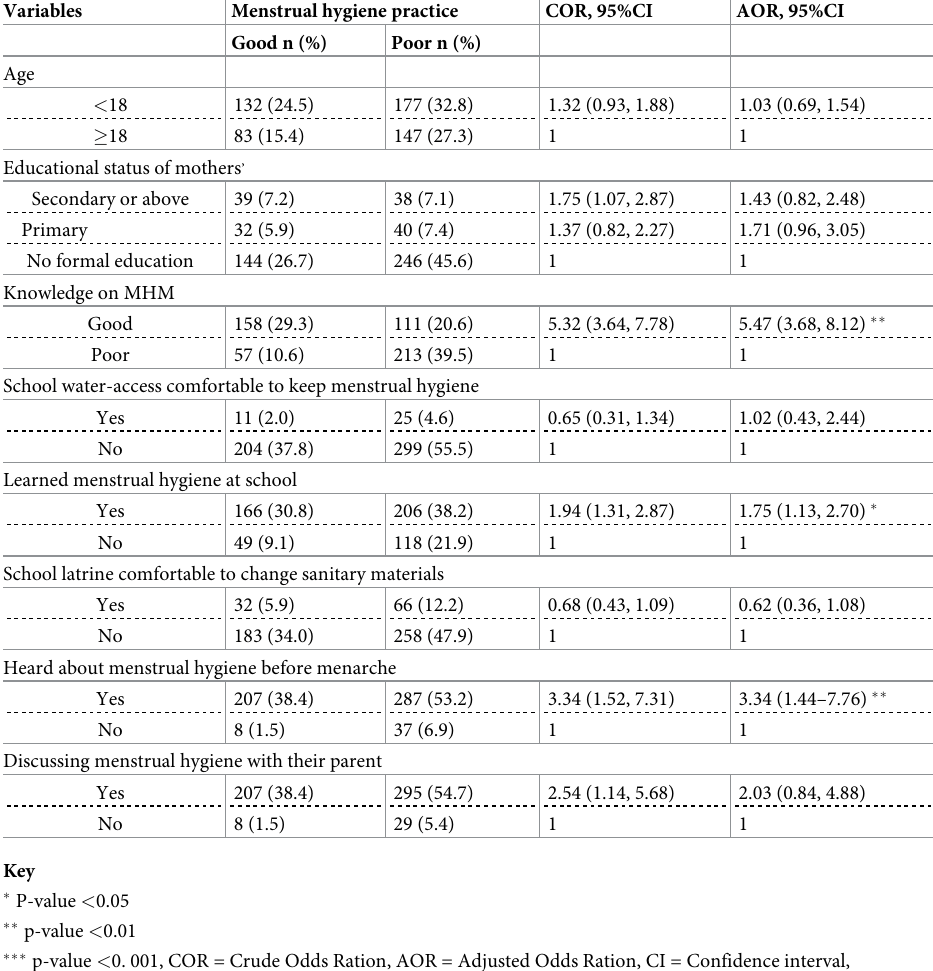
Table 5. Factors associated with menstrual hygiene management practice among rural schoolgirls in Northeast, Ethiopia, 2020 (n = 539).